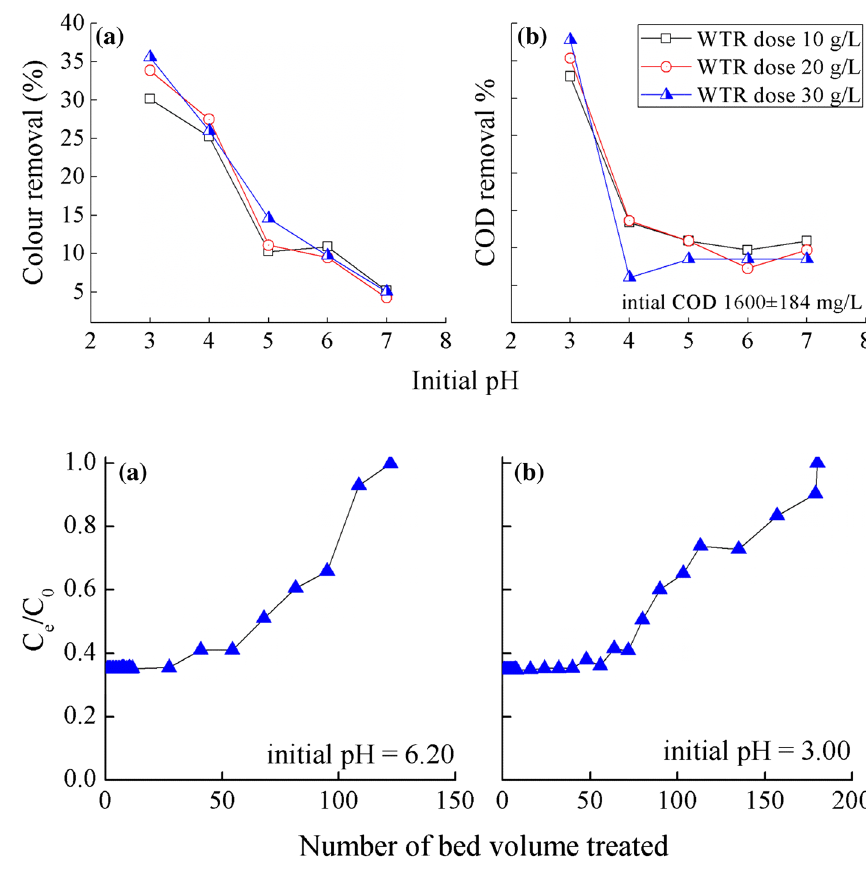
Fig. 6 Effect of pH on a colour and b COD removal at various WTR doses